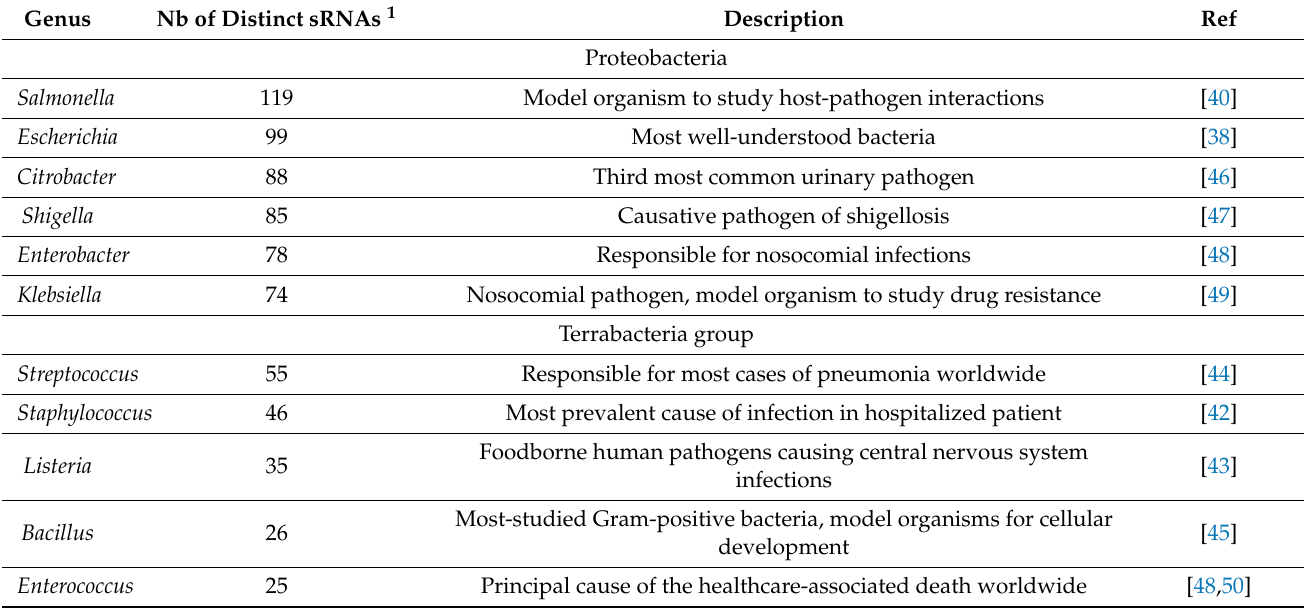
Table 2. Description of genus encoding for the most distinct